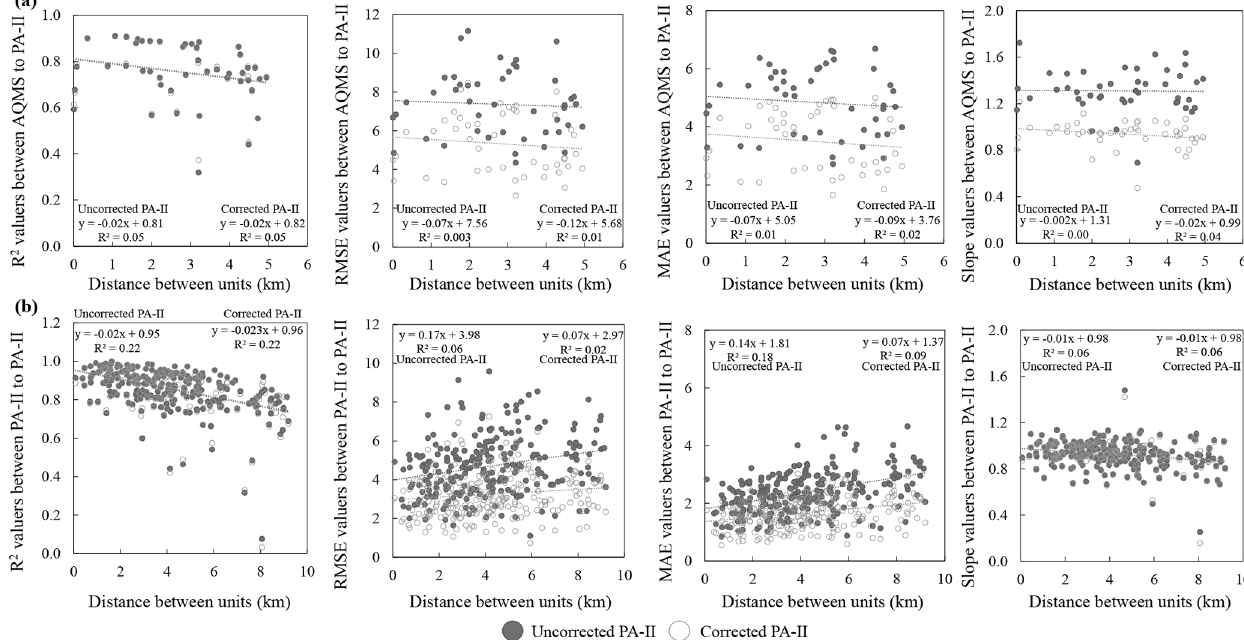
Figure 7. Comparison of distance (km) between PA-II and its nearest AQMS in all regions (a) and between each PA-II unit and all other PA-II units per region (b) for R 2 , RMSE, MAE, and slope values received from the PM 2 . 5 hourly measurements